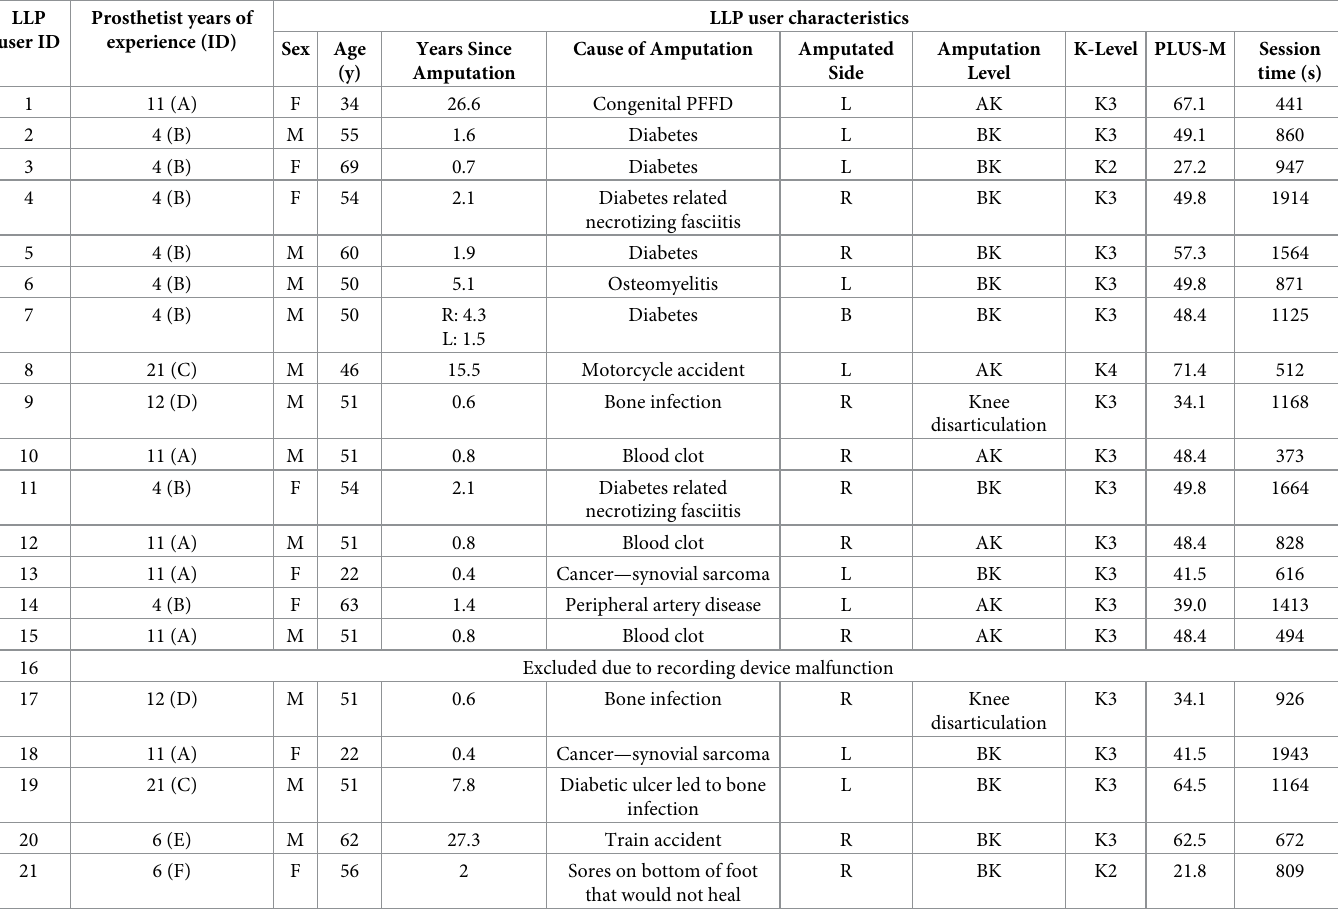
Table 2. Characteristics of the LLP users and treating